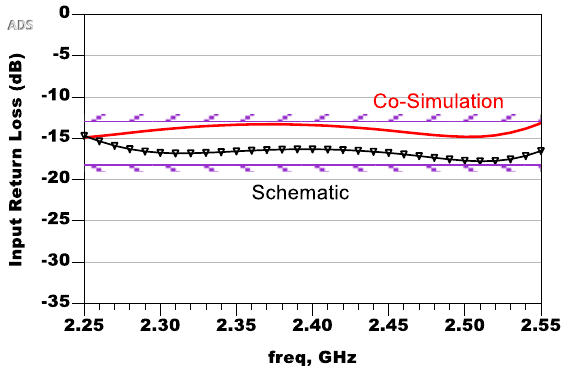
Fig. 13. Input return loss curves (schematic and EM Co- Simulation) versus frequency